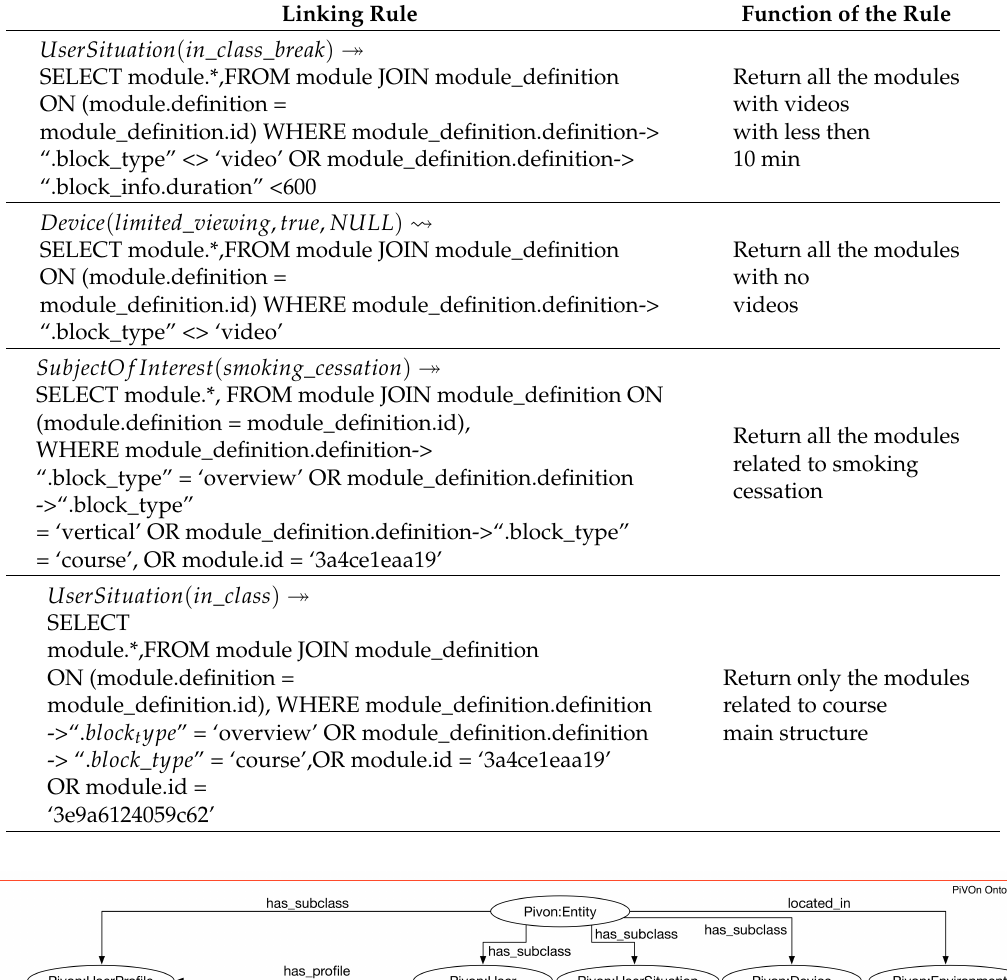
Table 9. Linking rules used in the evaluation.